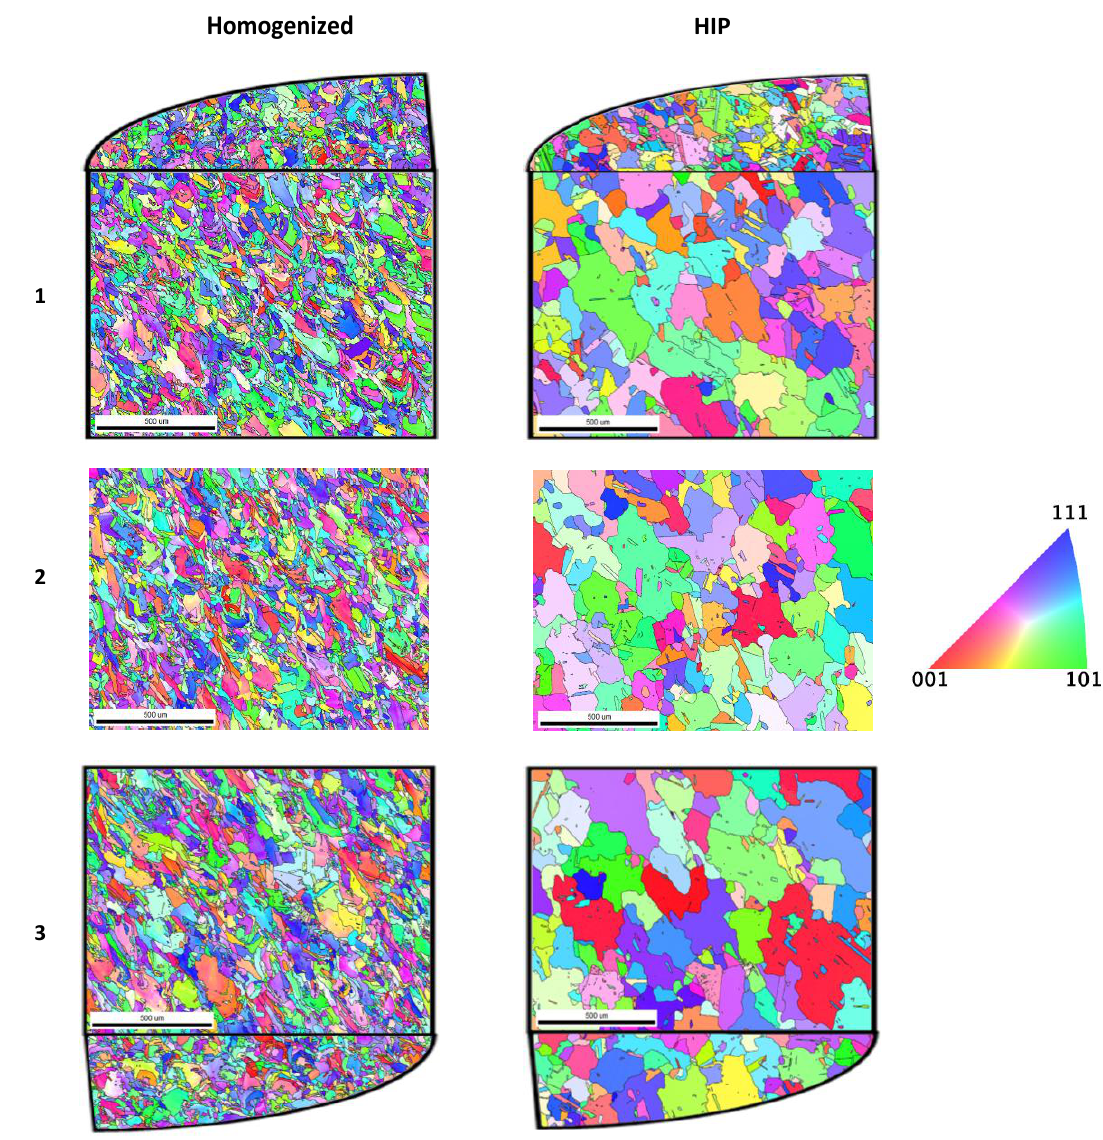
Figure 12. EBSD maps at the ( 1 ) top, ( 2 ) middle, and ( 3 ) bottom locations (illustrated in Figure 11) of the homogenized and HIP-treated specimens.